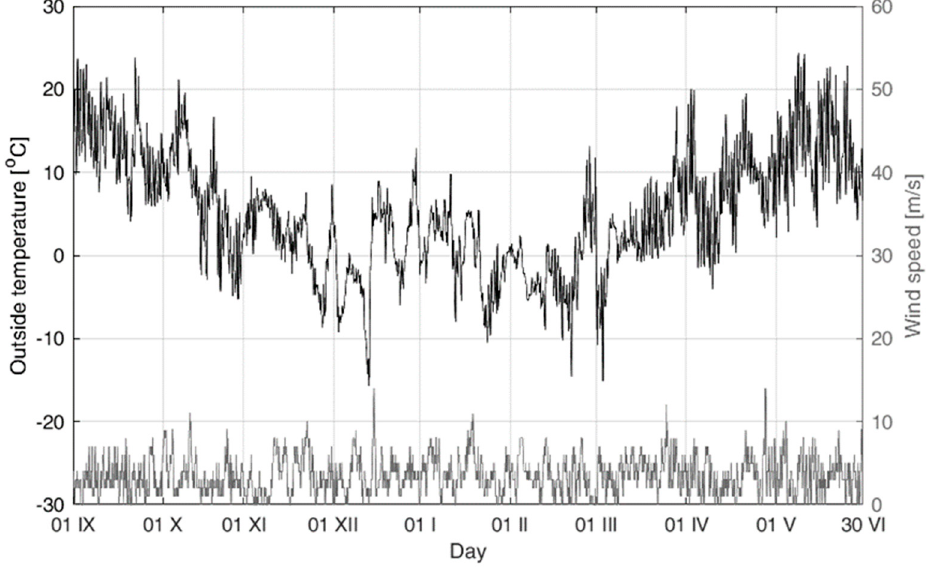
Figure 4. The outside temperature and wind speed in Pozna ń during the heating period.